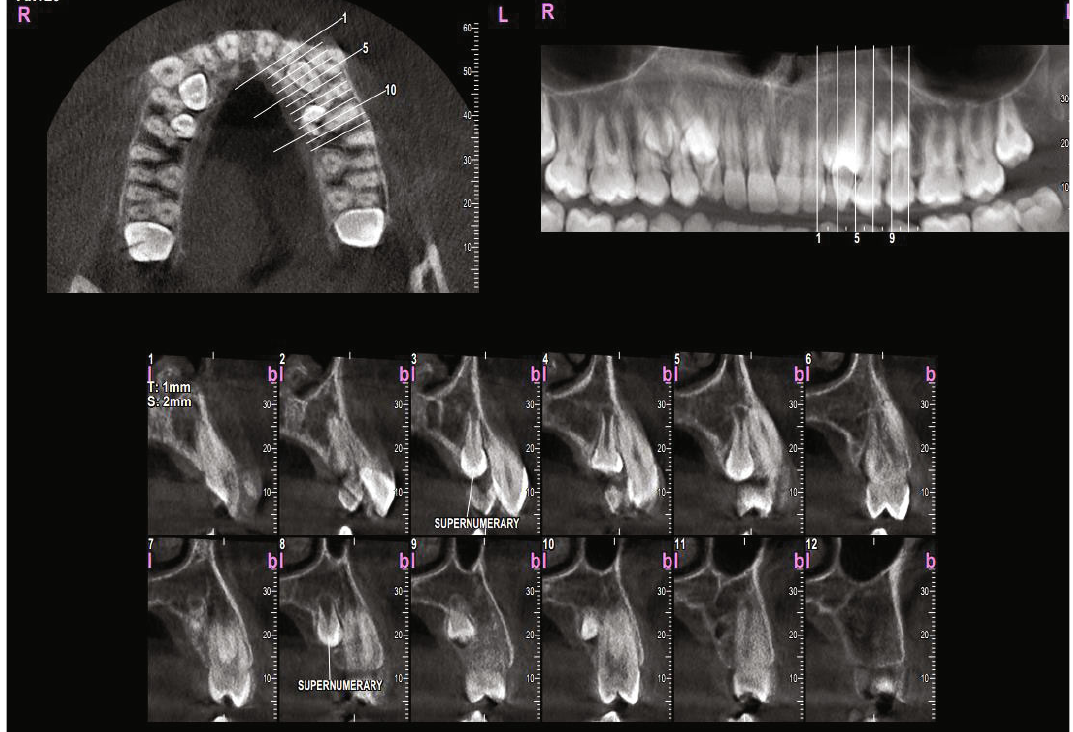
Figure 6: Vertical sections perpendicular to the alveolar ridge, showing the position and morphology of supernumerary teeth in the maxillary left